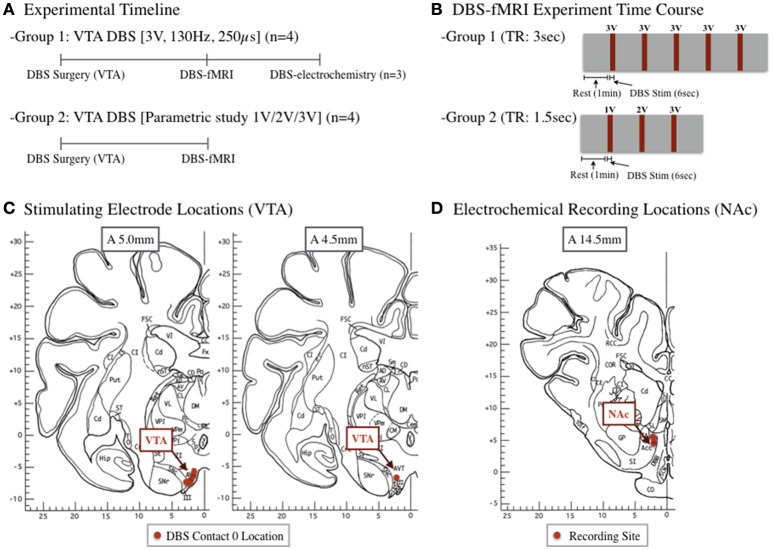
(A) A total of eight subjects underwent DBS surgery and had an electrode placed in the ventral tegmental area (VTA). Group 1 subjects (n = 4) underwent a standard stimulation protocol during fMRI, followed by subsequent electrochemistry (n = 3). A subset of subjects (Group 2, n = 4) underwent a parametric study following DBS surgery to evaluate the effects of varying amplitudes (1, 2, 3 V). (B) Group 2 subjects underwent a stimulation block design of 1 min rest, followed by a 6 s, 3 V stimulation, repeated 5 times. Group 2 design included a 1 min rest, followed by a 6 s, 1, 2, or 3 V stimulation. (C) Location of VTA stimulating electrode (contact 0). (D) Location of electrochemical recording electrode in the nucleus accumbens of each subject. Pig brain atlas used from Félix et al. (1999).